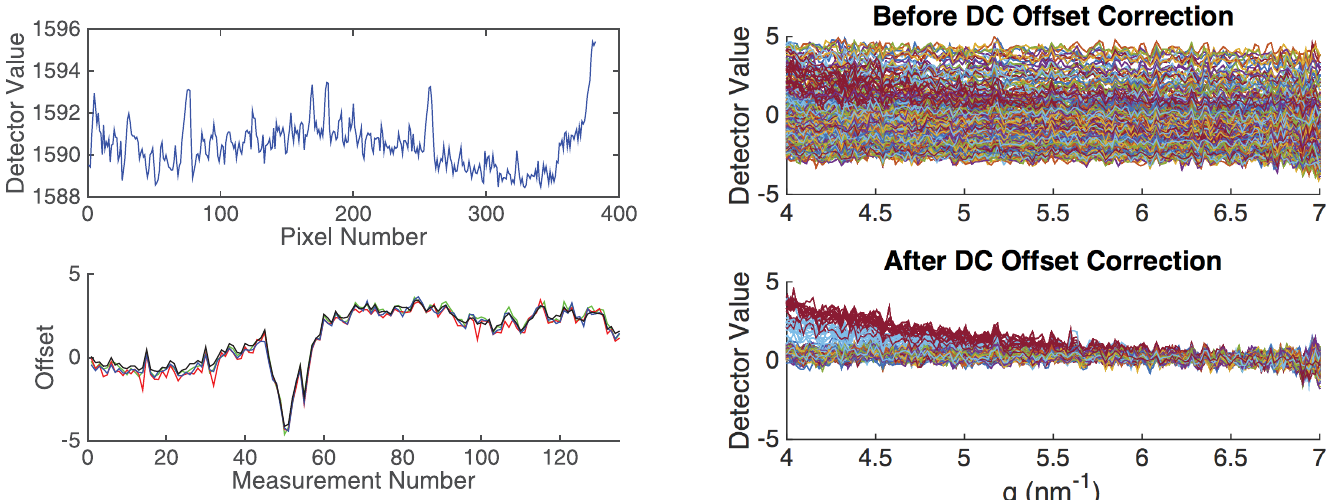
Fig 3. (Top left) Dark current (DC) measurement. (Bottom left) Plot of detector values after dark current subtractionat a few angular positionsfor all scatter measurements (6.52, 6.54, 6.56 nm − 1 ). The black line is an averageof 31 angularpositions rangingfrom 6.52 to 7.08 nm − 1 . (Top right) All measurements plotted by q after dark current subtraction, but before dark current offset correction. (Bottom right) All measurements plotted by q after dark current subtraction, and after dark current offset correction.